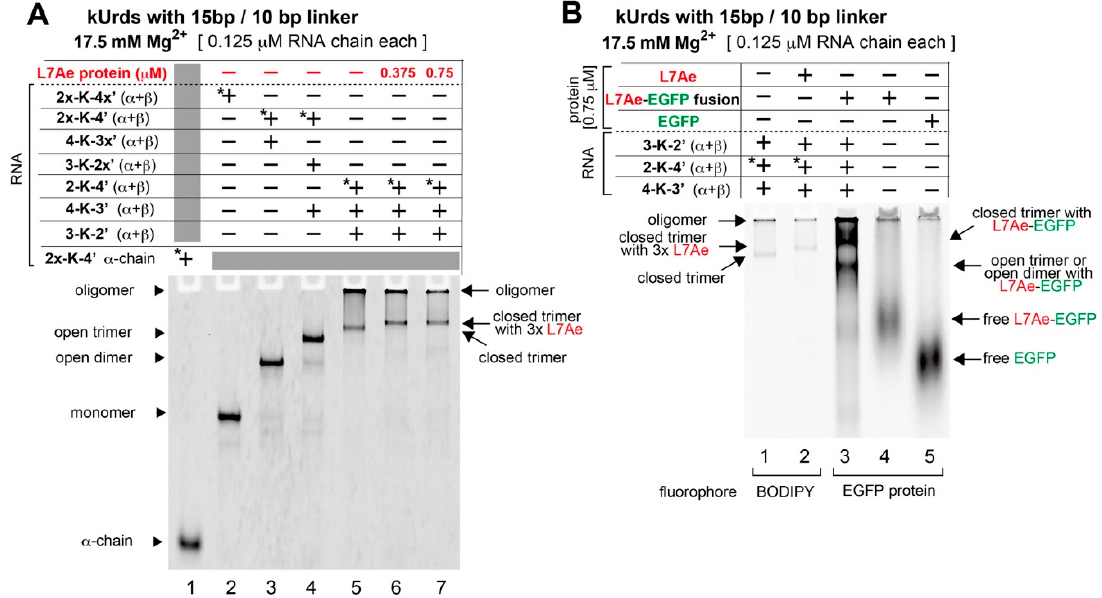
Figure 5. Complex formation of L7Ae protein with KT-15 kink-turn motifs in a closed kUrd heterotrimer. ( A ) EMSA of a closed kUrd heterotrimer in the absence and presence of L7Ae protein. ( B ) EMSA of a closed kUrd heterotrimer in the absence and presence of L7Ae protein and L7Ae-EGFP fusion protein.